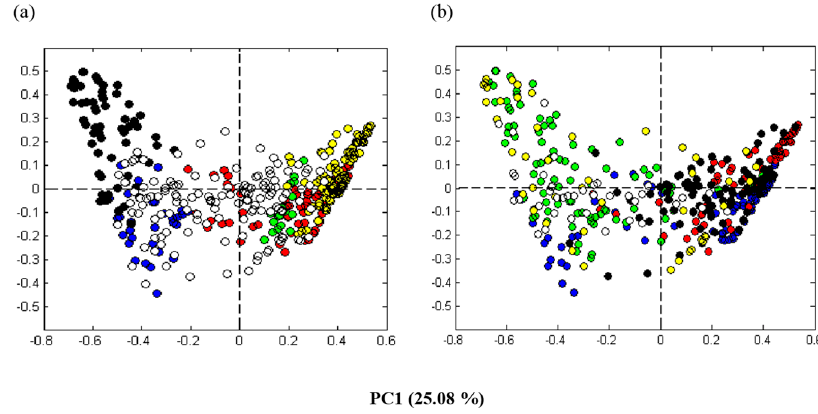
Figure 3. Score plots of the principal component analysis (PCA) for the pre-processed aligned partial 16S rRNA gene spectra. Rakfisk brine samples were collected from the six producers throughout the ripening period during two years (see Table 1). ( a ) The data points visualized according to the bacterial taxa corresponding to the dominating MCR (multivariate curve resolution) component of each sample; blue: Gammaproteobacteria (component 1), red: Bacillales (component 2), green: Lactobacillales (component 3), black: Psychrobacter (component 4), yellow: Lactobacillus (component 5), and white: none of the components were above 50%. ( b ) The data points visualized according to the six different rakfisk producers; 1: green, 2: blue, 3: black, 4: red, 5: yellow, 6: white.